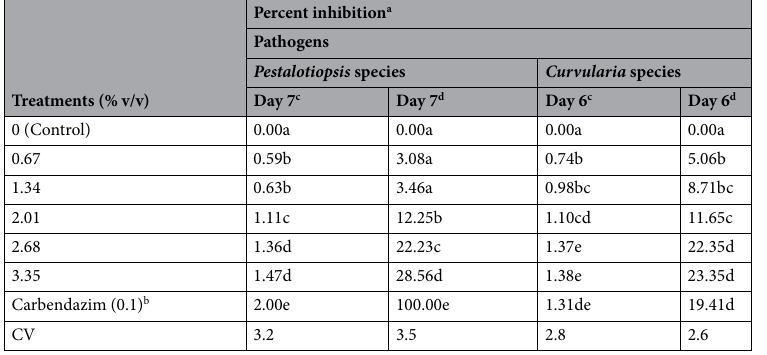
Table 1. Percentage inhibition of pathogens at different concentrations of the Organic Farming Aid (Wood vinegar). a Percentage inhibition was calculated from mean values of colony diameter obtained from the various concentrations. b Carbendazim was a positive control and the manufacturer’s recommended rate was duly applied. c Log transformed data. d Untransformed data.